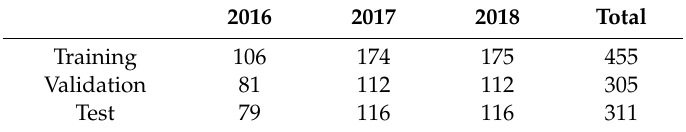
Table 2. Number of training, validation and test samples used in each experiment.